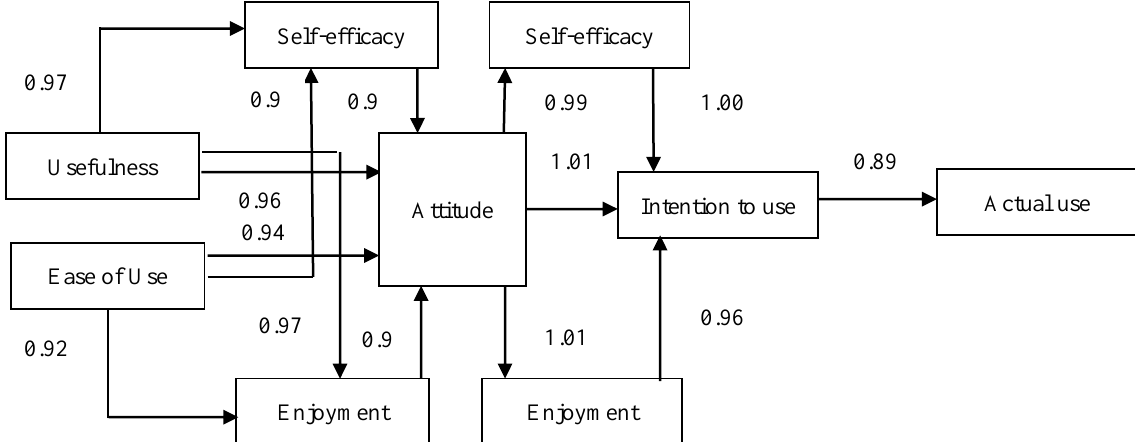
Figure 5. Regression analysis of the TAM constructs for pre-service teachers' acceptance of digital tools for